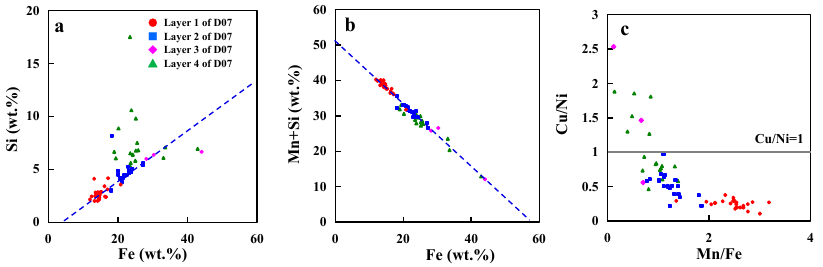
Figure 10. ( a , b ): Si and Mn+Si versus Fe; ( c ): In Si-rich layers Cu > Ni.